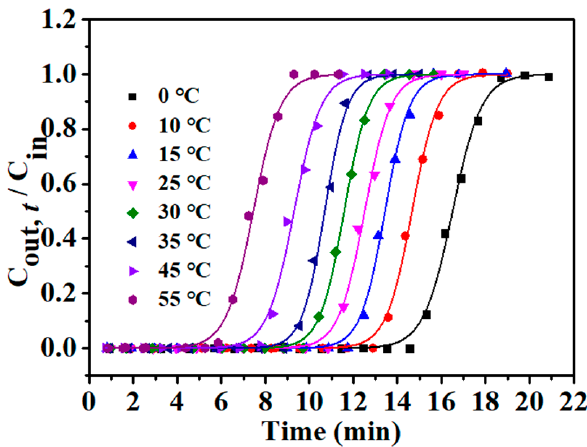
Figure 11. Adsorption breakthrough curves for β -CD-rGOA-0.5 at different temperatures by Yoon–Nelson model. Table 3. Influence of the temperature on the adsorption of L2 over β -CD-rGOA-0.5 a . Temp. ◦